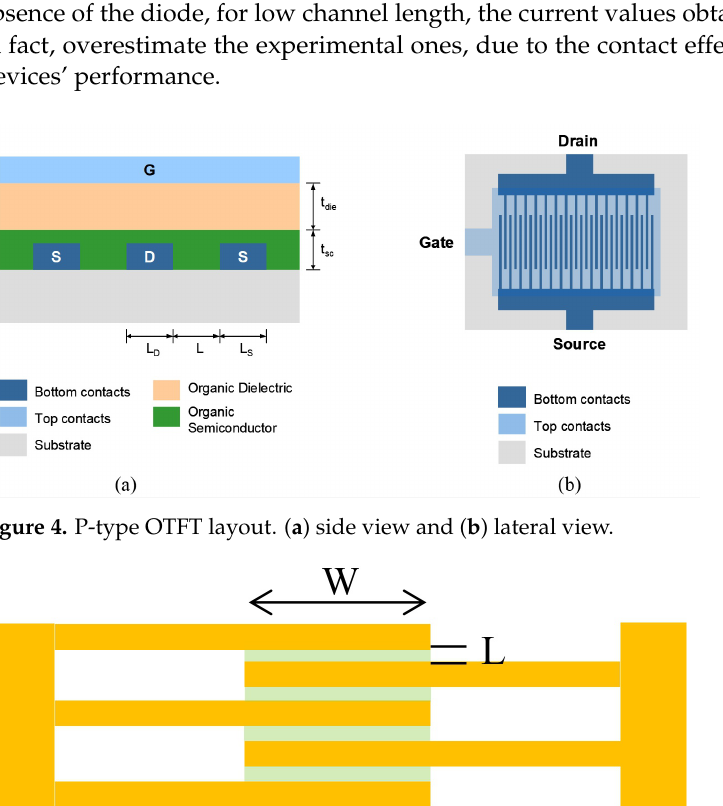
Figure 5. P-type OTFT multi-fingers structure of source-drain electrodes.